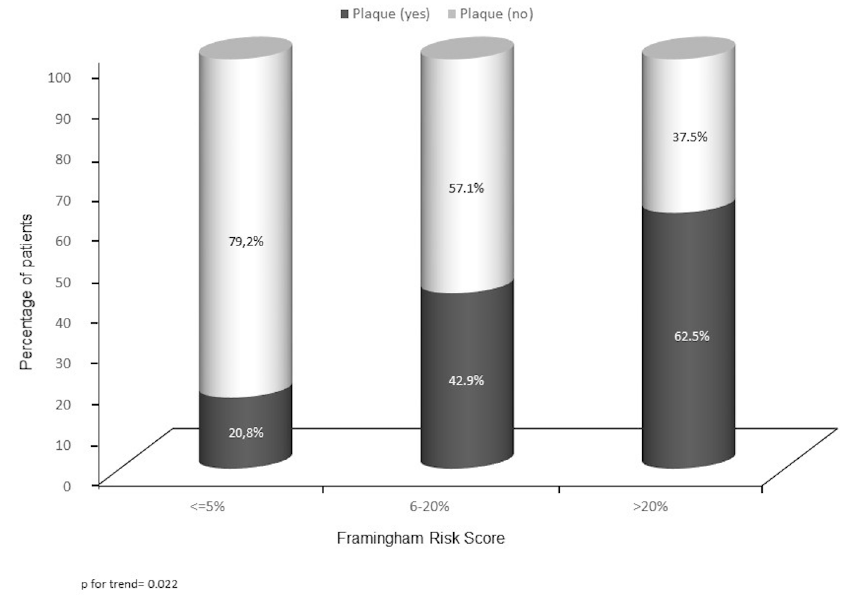
Fig 1. Frequency of carotid plaques by each Framingham risk score based